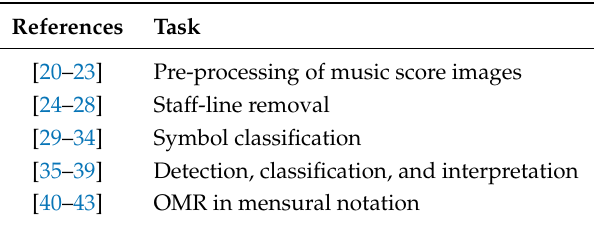
Table 1. Representative summary of previous works in OMR